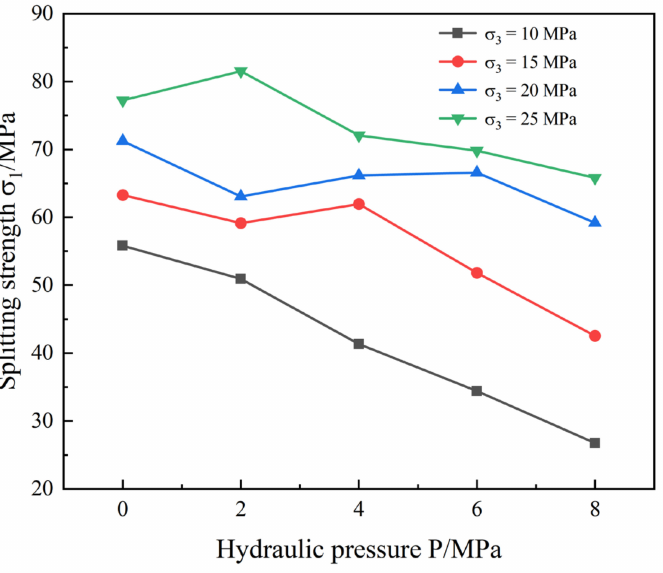
Figure 2. Splitting strength values under different hydraulic pressures [33].